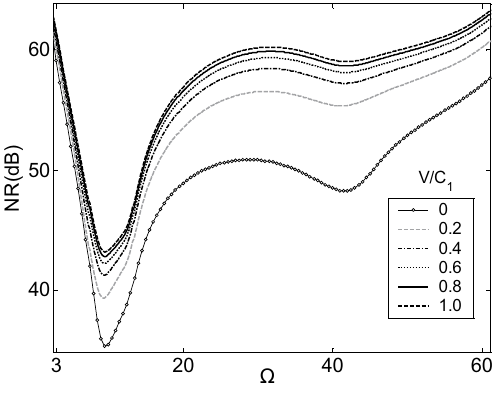
Fig. 14. Effects of different external medium velocity on the noise